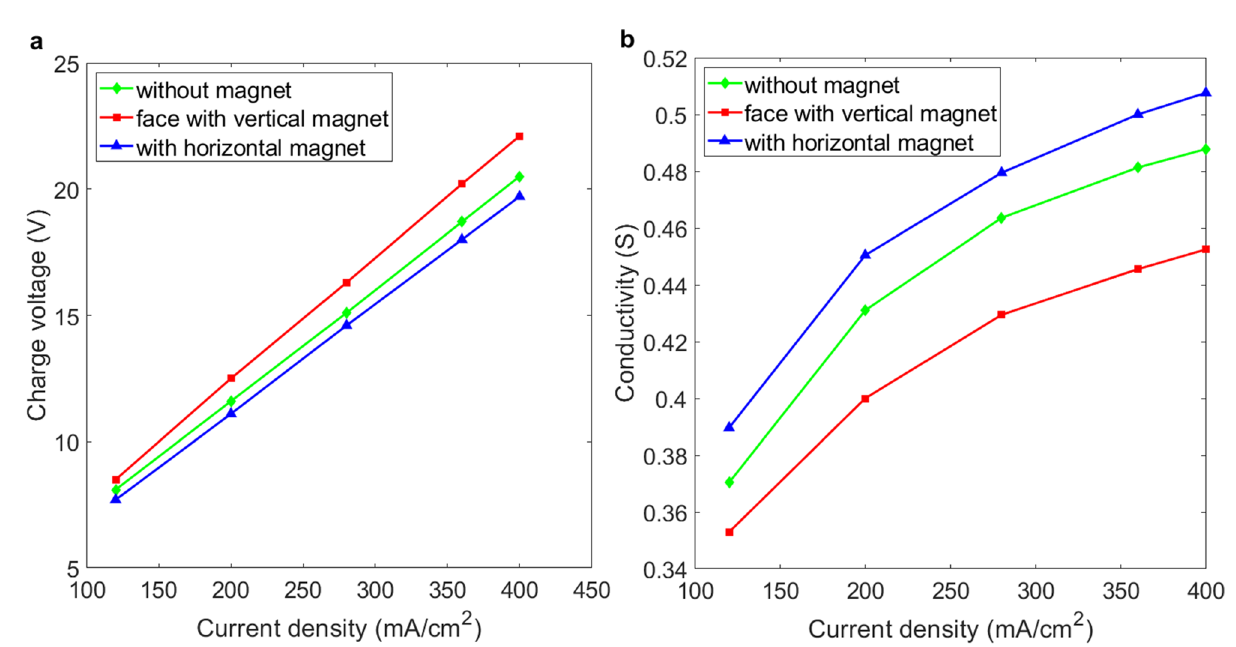
Figure 6. Comparison of the conductivity for vertical platinum electrodes in various magnetic field configurations. ( a ) Charging voltage vs. current density for the experimental layout in Fig. 1d–f. ( b ) Conductivity vs. current density for the experimental layouts in Fig.